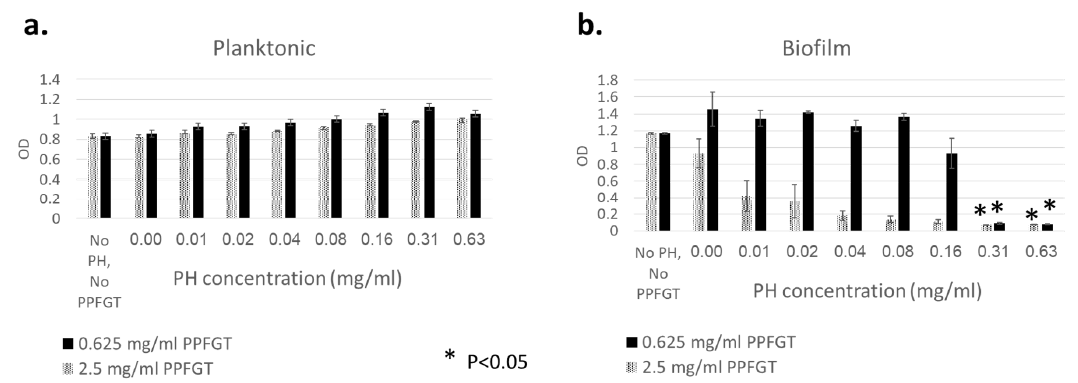
Figure 1. Total biomass of planktonic and biofilm cells of C. albicans and S. mutans stained with crystal violet. ( a ) OD of planktonic cells with increasing concentrations of PH. ( b ) OD of biofilm with increasing concentrations of PH. Error bars indicate the standard deviation ( n = 96).